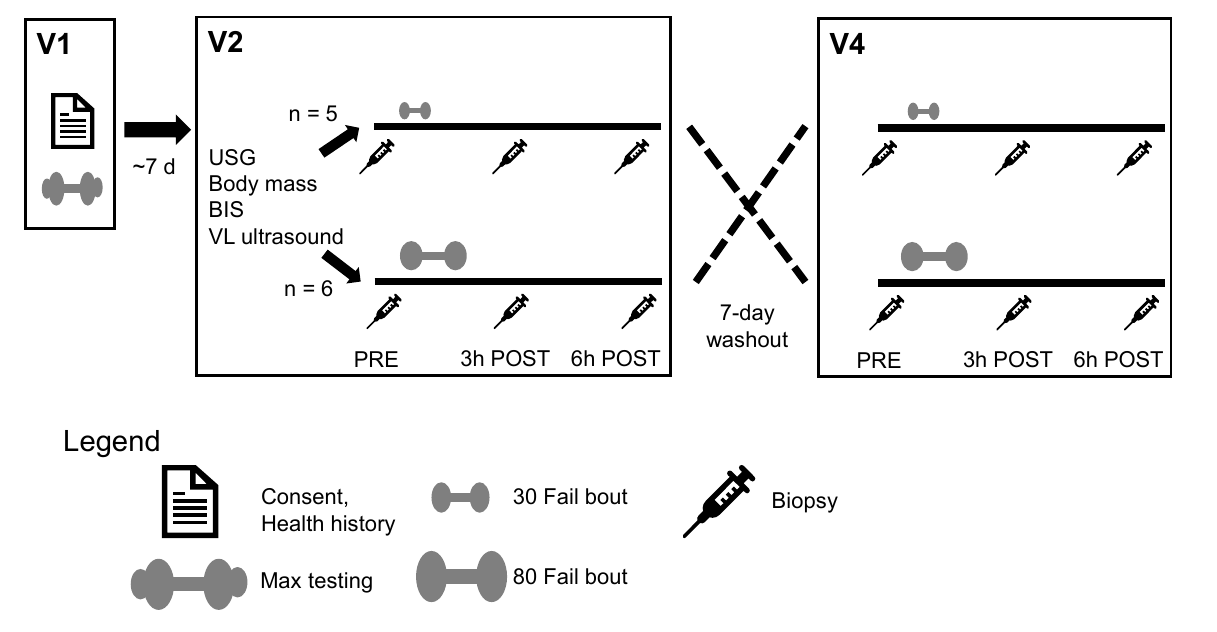
Figure 1. Study design. This schematic represents the timeline for participant consent, max testing, PRE- phenotype testing, experimental resistance exercise bouts, cross-over washout period, and time points for all biopsies. Abbreviations: 30 Fail, 30% one repetition maximum to failure; 80 Fail; 80% one repetition maximum; BIS, bioelectrical impedance spectroscopy (for body composition); USG, urine-specific gravity testing; V1/V2/V4, Visits 1/2/4; VL, vastus lateralis.